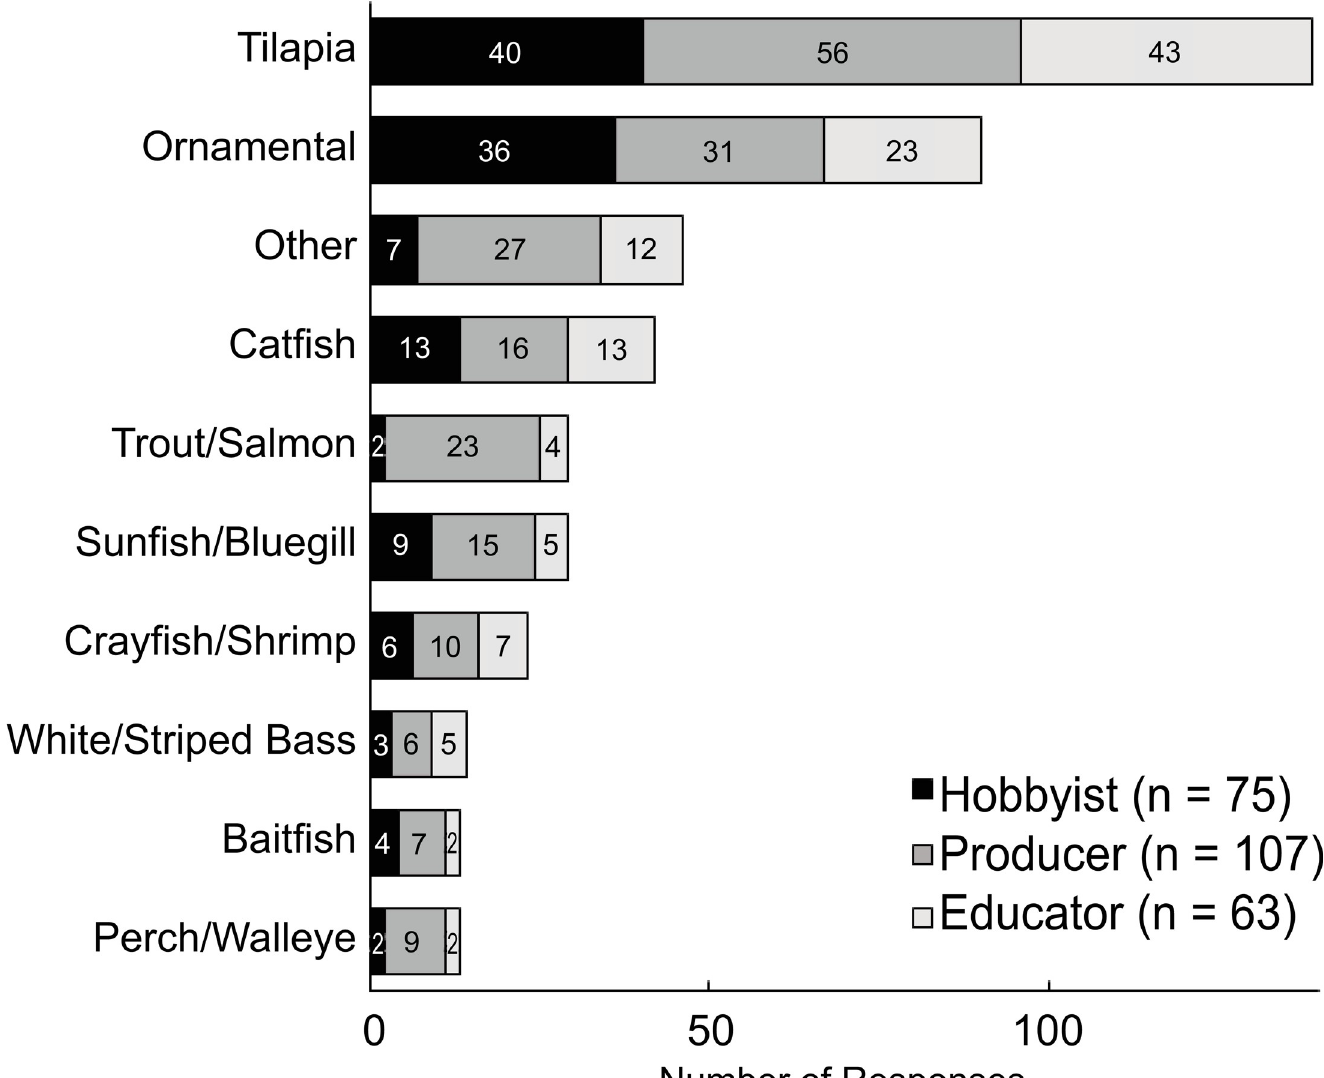
Fig 6. Frequency of fish species production by aquaponic hobbyists, producers, and educators. Numbers present within the bars represent the total number of selections made by each stakeholder group. Note–“Other” fish species grown included white seabass, paddlefish, northern pike, crappie, pumpkinseed sunfish, heat- tolerant tiger trout, arctic char, white sturgeon, sleepy cod, tenca, snakehead, Clarias catfish, and mummichog.